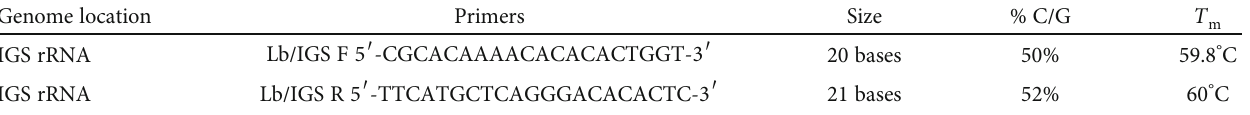
Table 8: Set of primers speci fi c for Leishmania braziliensis targeting the IGS rRNA region. Genome location